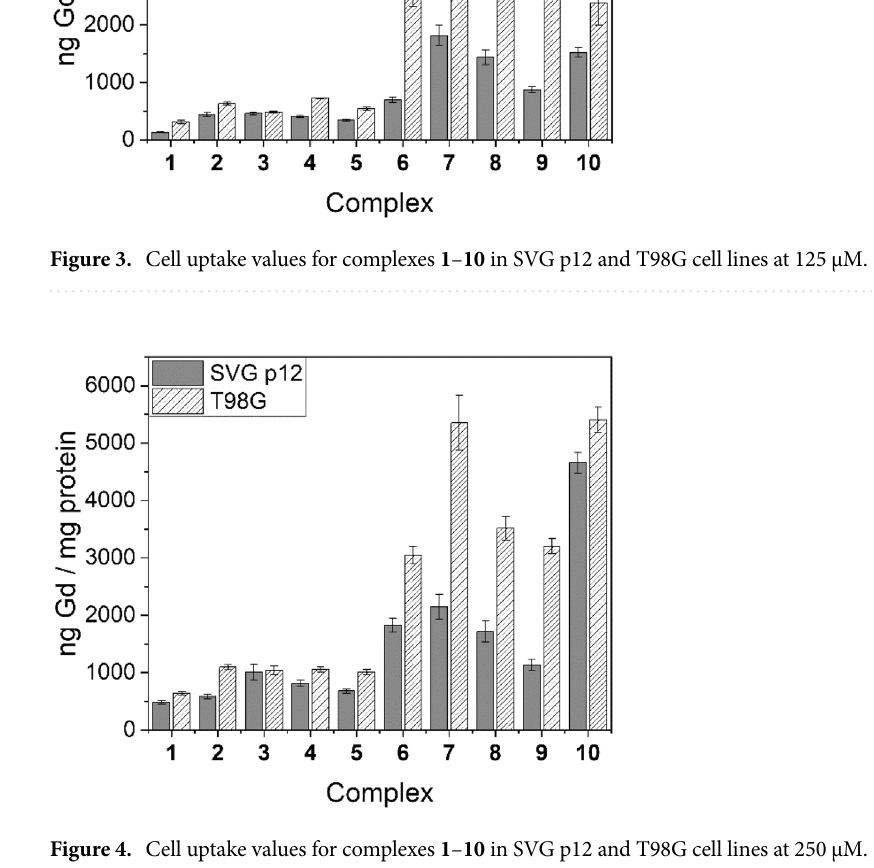
Figure 4. Cell uptake values for complexes 1 – 10 in SVG p12 and T98G cell lines at 250